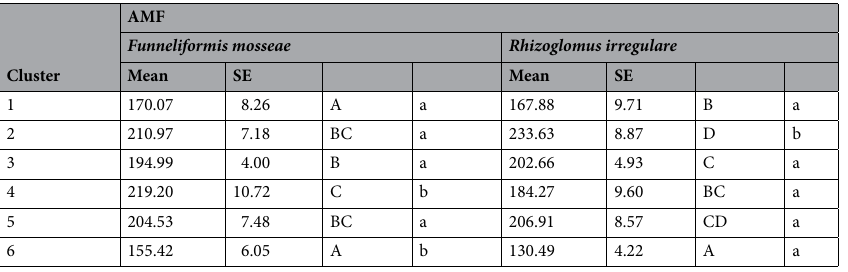
Table 4. S hoot dry weight of tetraploid wheat plants (means and standard errors, SE), by arbuscular mycorrhizal fungus (AMF) and genetic clusters. Means followed by the same letter do not differ significantly (P < 0.05). Capital letters (in columns) refer to differences among clusters within Funneliformis mosseae or Rhizoglomus irregulare treatments. Small letters (in rows) refer to differences between AMF within a cluster. Simple effect test with Sidak correction.